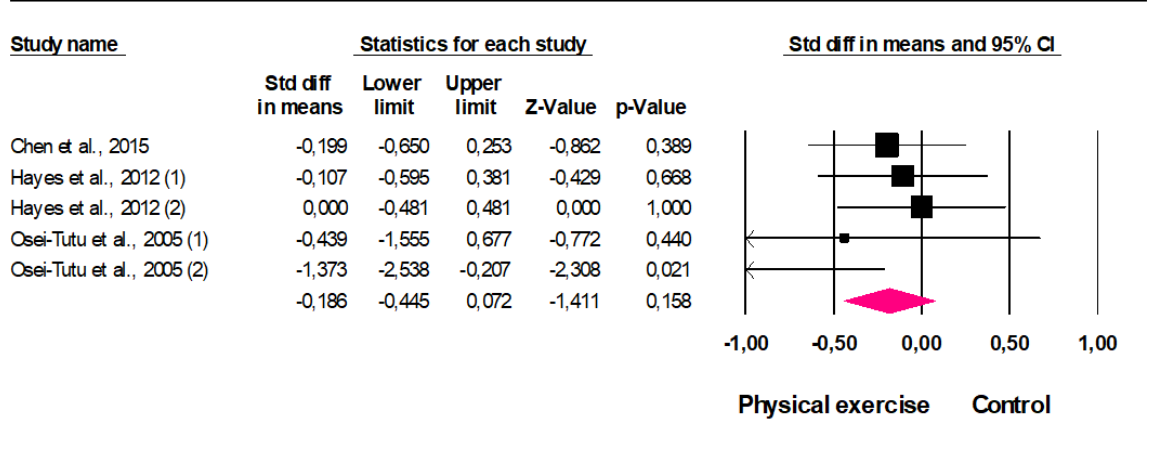
Figure 2. Forest Plot (fixed